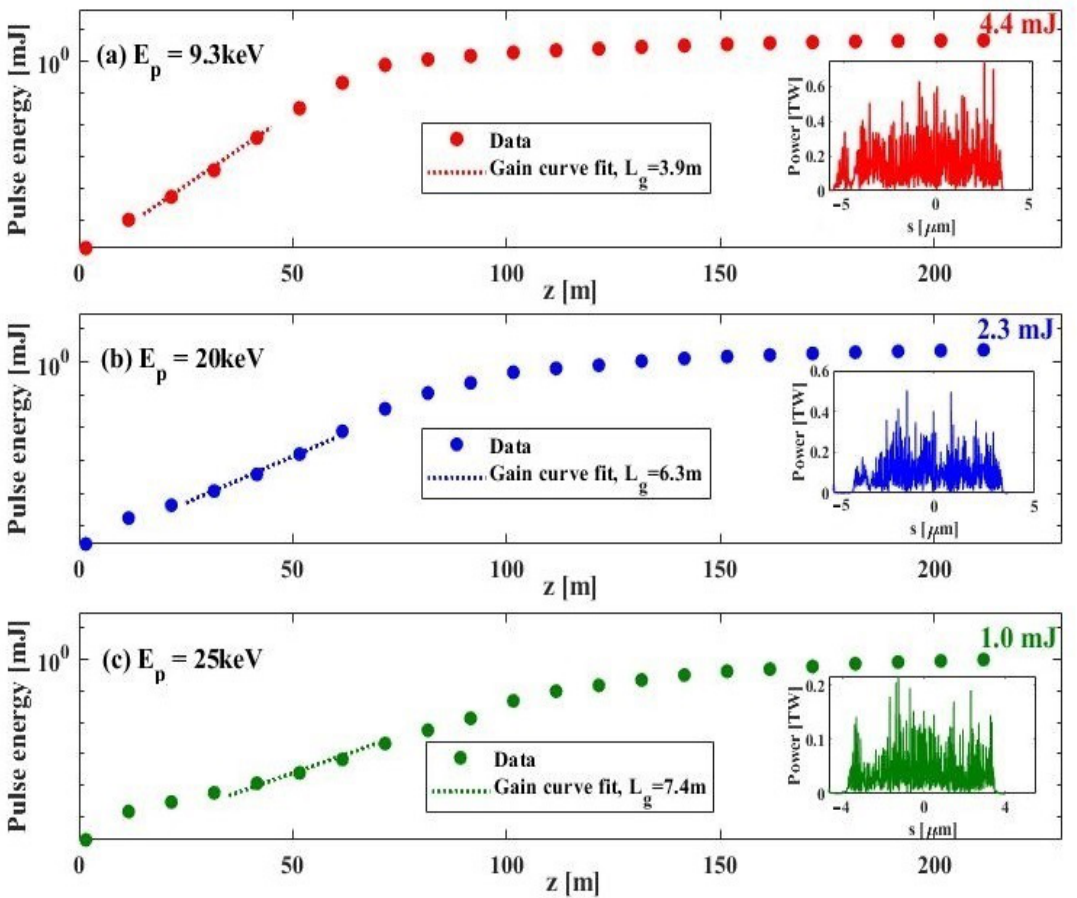
Figure 8. SASE performance in the sub-ångström regime using electron bunches produced with a 56.3 MV/m cathode accelerating gradient at a total beam energy of 14 GeV. Pulse energies along the undulator beamline are shown for ( a ) 9.3 keV; ( b ) 20 keV; ( c ) 25 keV; The dashed lines show the exponential fits to the gain curves for estimating the gain lengths. Note that the impact of the intersection length of neighbouring undulator sections are already excluded as calculating the gain length. The inset plots show SASE power distributions at the end of the undulator beamline. The inset numbers indicate saturation pulse energies. For each case, 30 simulations are performed with random noise seeds. The statistical standard deviations of the achievable SASE intensities are up to